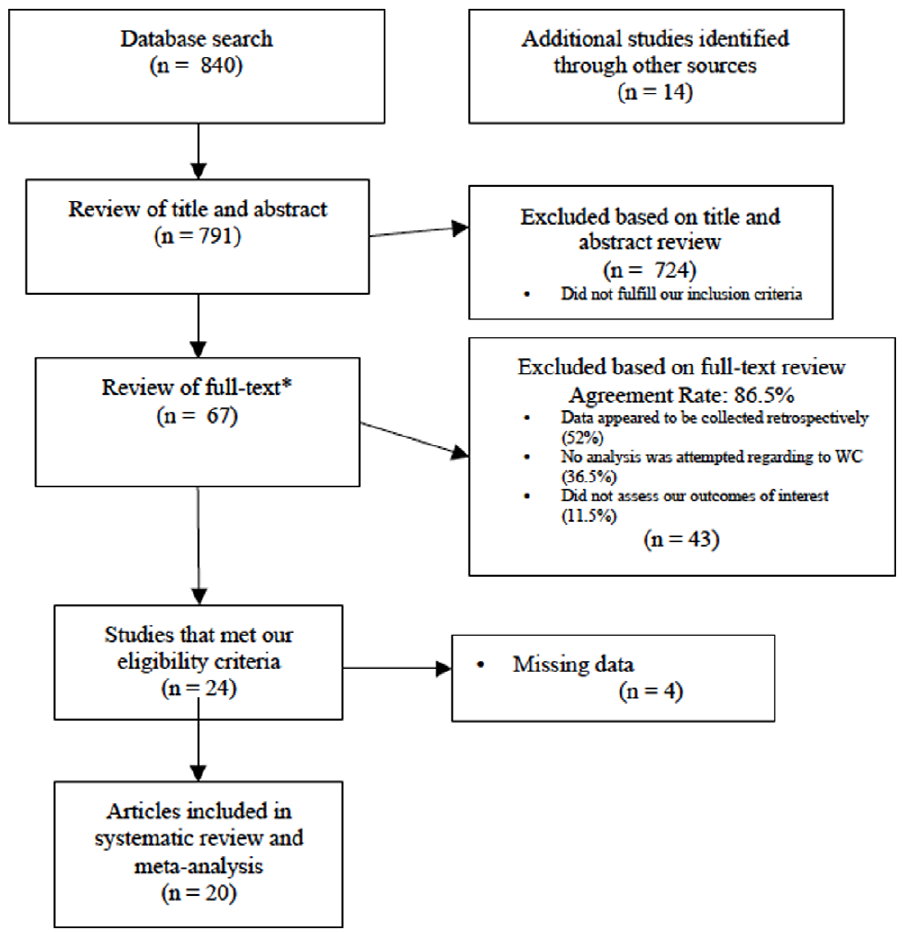
Figure 1. Flow Chart of Study Process. This figure demonstrates the various stages of our systematic review and depicts the reasons why certain papers were excluded.